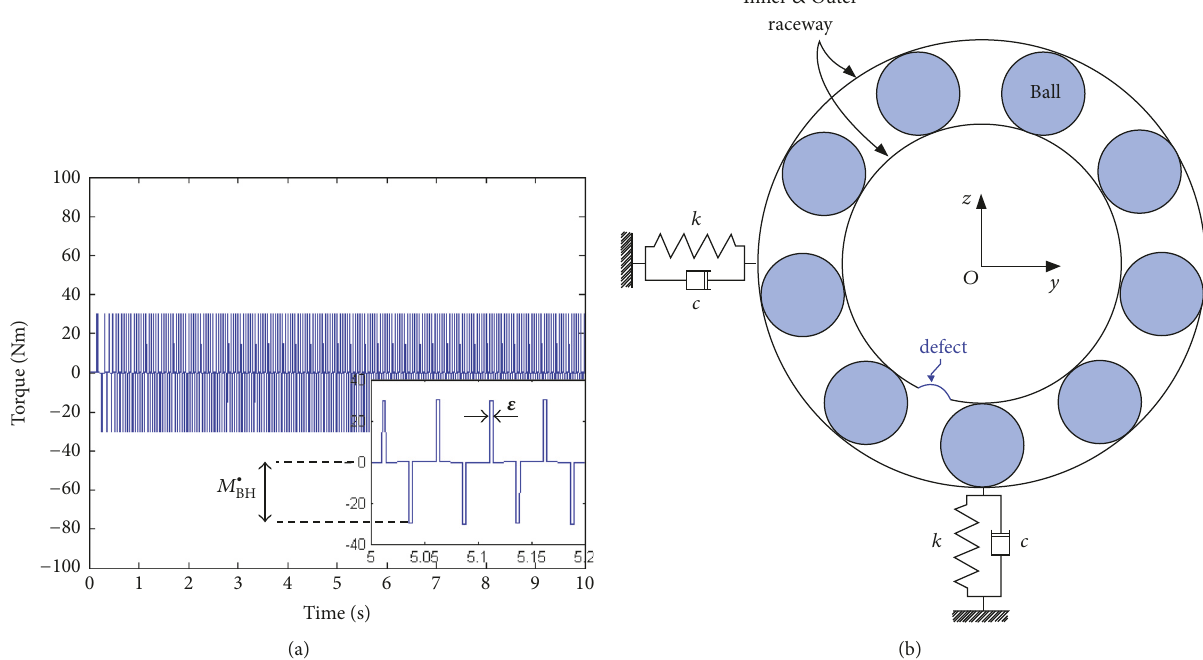
Figure 5: Typical disturbance torque ( 𝑀 ∙ BH ) with zoom (a) and inner race defect modelling sketch with rolling bearing elements (b).